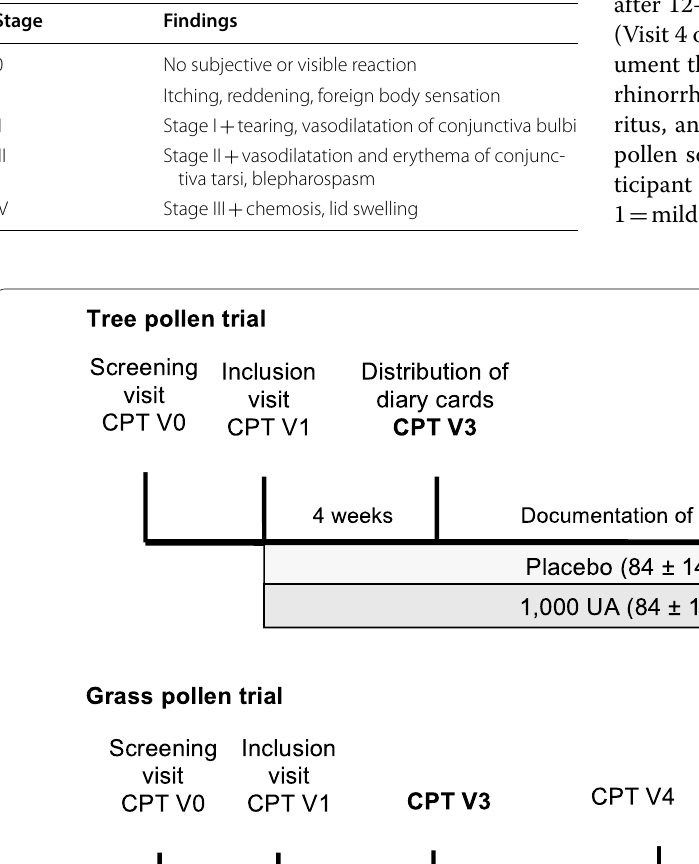
Table 1 Stages of the reactions to the conjunctival provocation test (CPT) according to Riechelmann et al. [18]